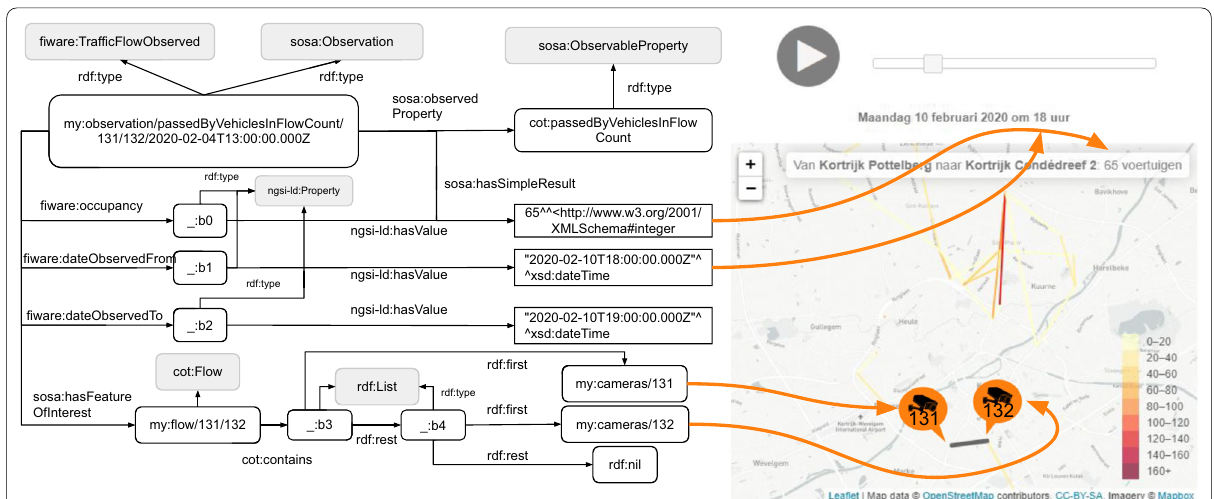
Fig. 7 Flows visualization. There are 65 vehicles counted between Pottelberg and Condédreef indicating urban